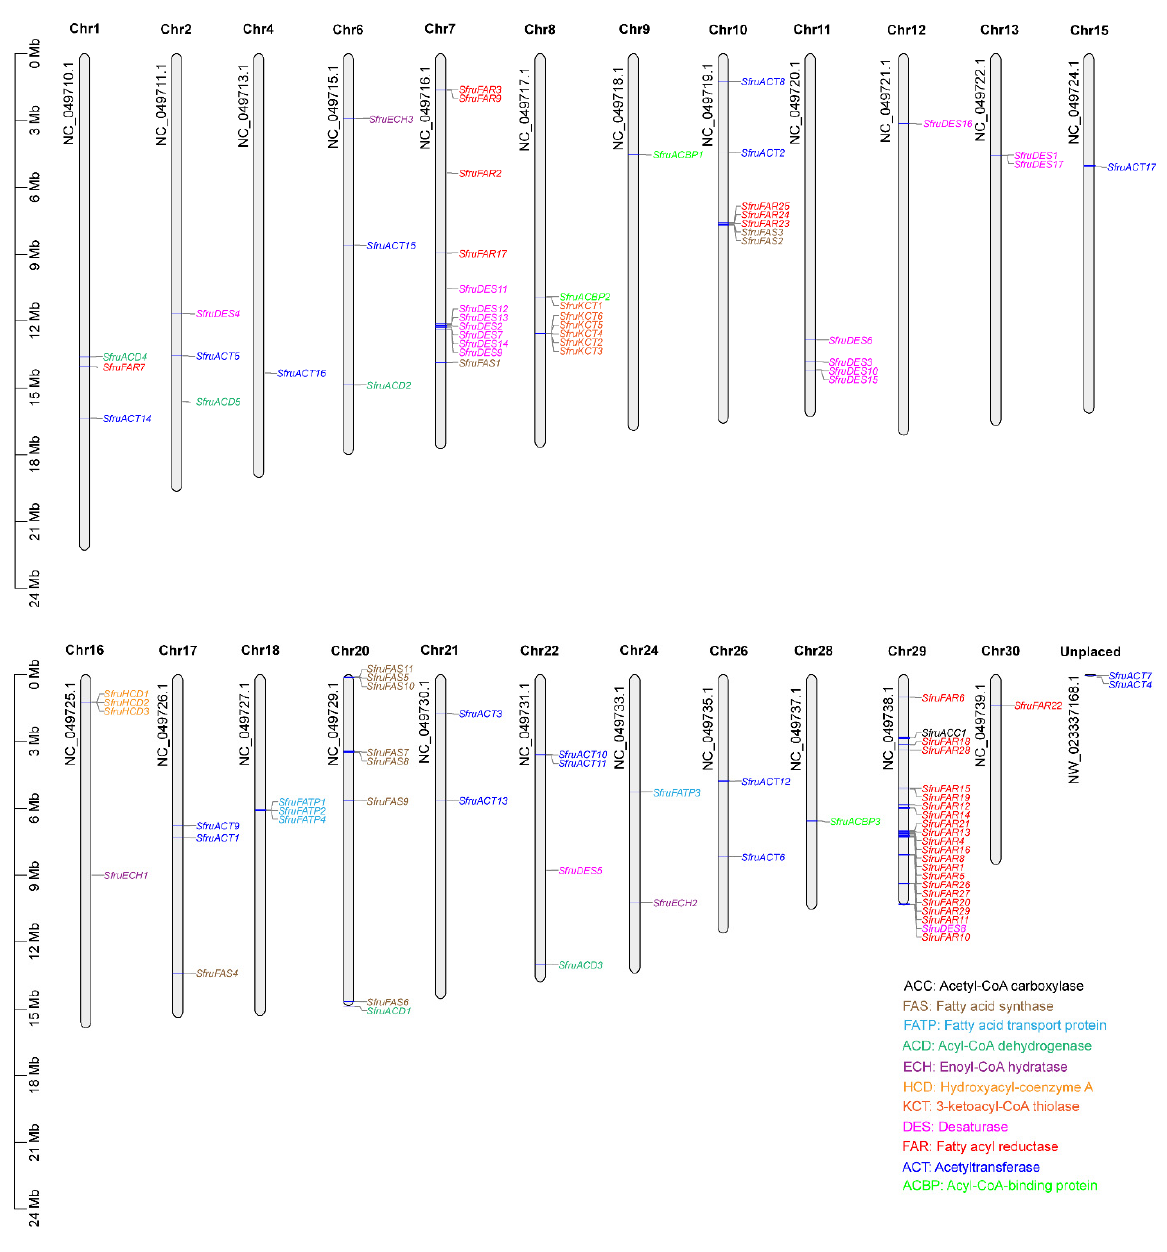
Figure 1. Localization of the candidate sex pheromone biosynthesis genes in the S. frugiperda genome. According to the annotation file of S. frugiperda , we determined the sex pheromone biosynthesis gene locations in the genome.